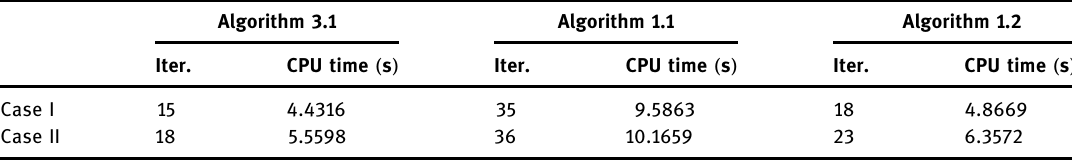
Algorithm 3.1 Algorithm 1.1 Algorithm 1.2